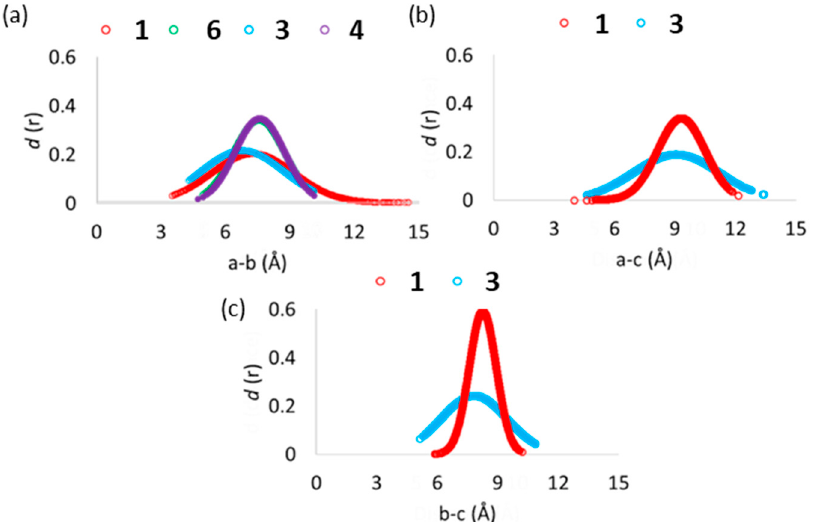
Figure 6. Distance distributions obtained from the MD trajectories for the groups comprising com- pounds 1 , 3 , 4 and 6 . Labels ( a – c ) were assigned according to Scheme